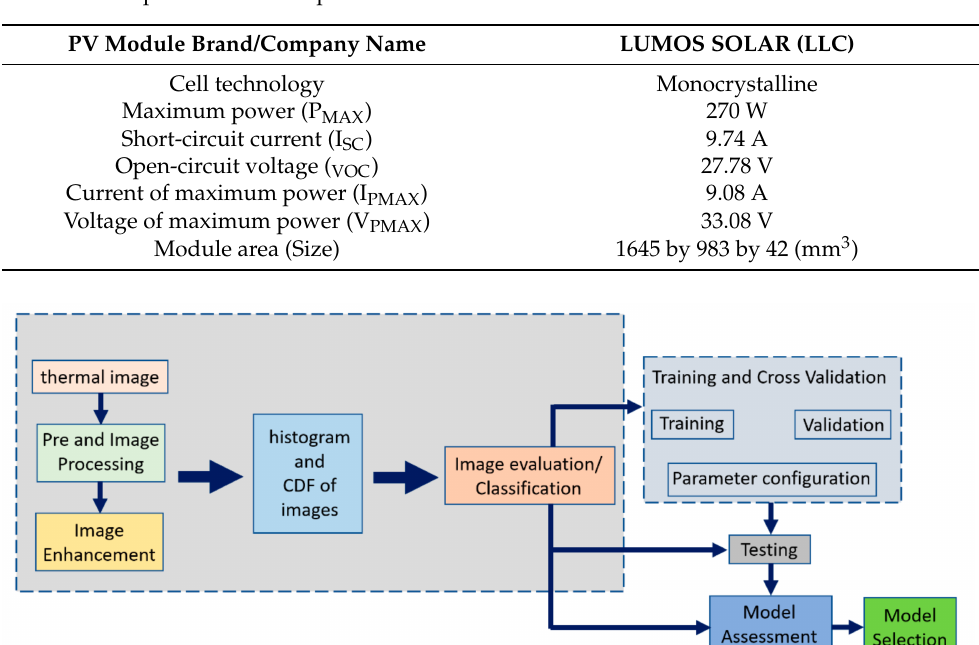
Table 2. Solar panels technical specifications.